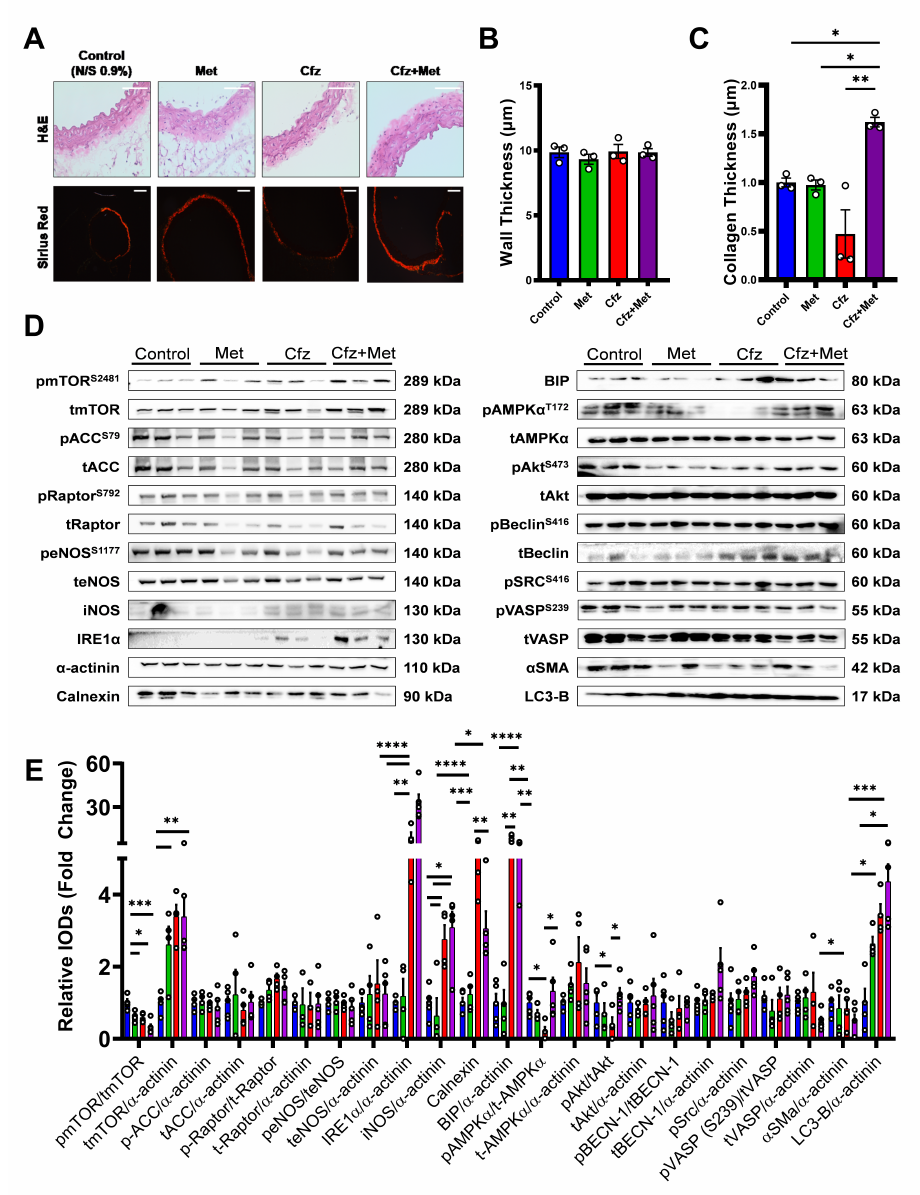
Figure 3. Carfilzomib and metformin monotherapies do not induce any changes in the vascular phenotype, while the combination of Cfz + Met leads to increased collagen deposition on the vessels and a synergistic induction of an ER-stress / AMPK α / LC-3B dependent autophagy. ( A ). (Upper Panel) Representative images of hematoxylin–eosin (H&E) staining of murine aortas (magnification 40 × ; scale bar 40 µ m; Lower Panel) Representative images of Sirius red staining (magnification 20 × ; scale bar 40 µ m). Graphs of ( B ) aortic wall thickness ( µ m) and ( C ) collagen thickness ( µ m) (* p < 0.05, ** p < 0.01, one way ANOVA, Tukey’s multiple comparison test; n = 3 per group). ( D ) Representative Western blot images of the studied protein targets and their phosphorylated forms. ( E ) Relative densitometry analysis of Western blot analysis, presented as fold change of the control (* p < 0.05, ** p < 0.01, *** p < 0.005, **** p < 0.001; one way ANOVA, Tukey’s multiple comparison test; n = 3 per group). Data are presented as mean ± SEM and individual values are presented as scatter column graphs. Blue lines / columns represent the control (Normal Saline; NS 0.9%), red lines / columns represent Cfz (8 mg / kg, ip), green lines / columns Met (140 mg / kg, per os) and purple lines / columns Cfz + Met (8 mg / kg, ip and 140 mg / kg, per os, respectively) in the 6 days protocol (subacute protocol). Cfz, Carfilzomib; Met,